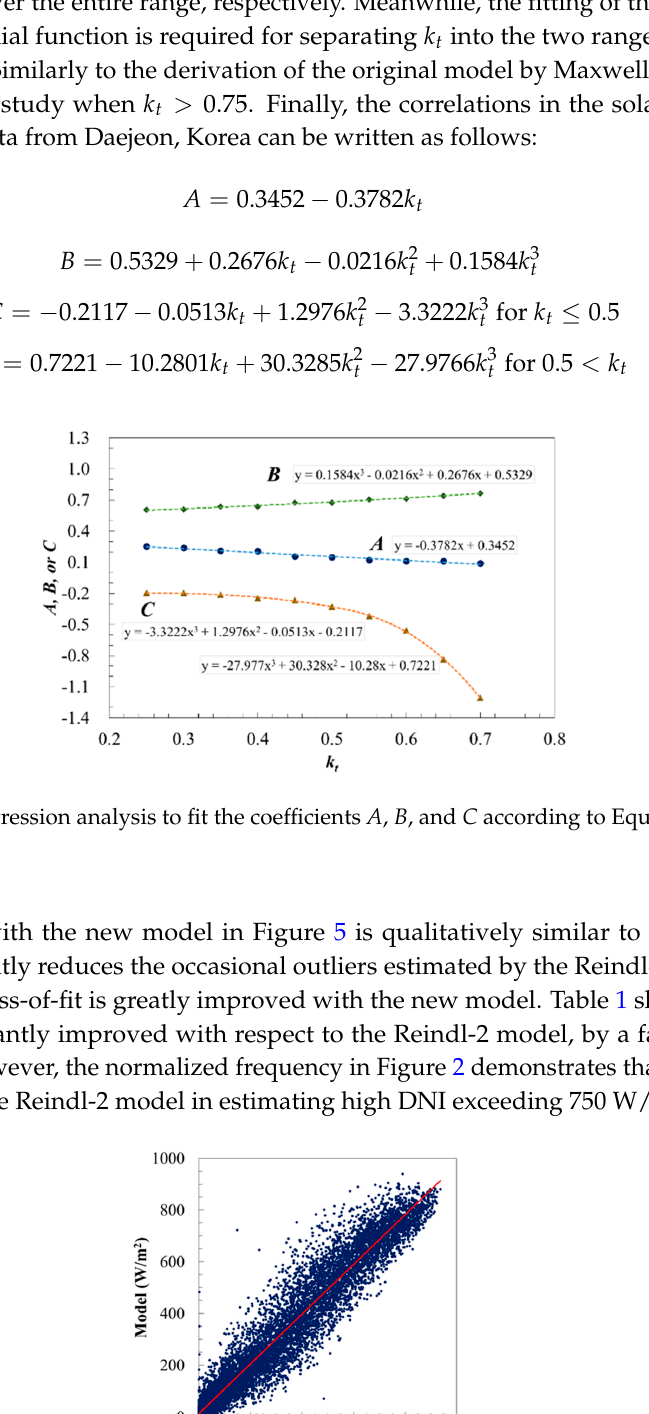
Figure 5. Scatterplot of the DNI measurement and estimation from the new model.